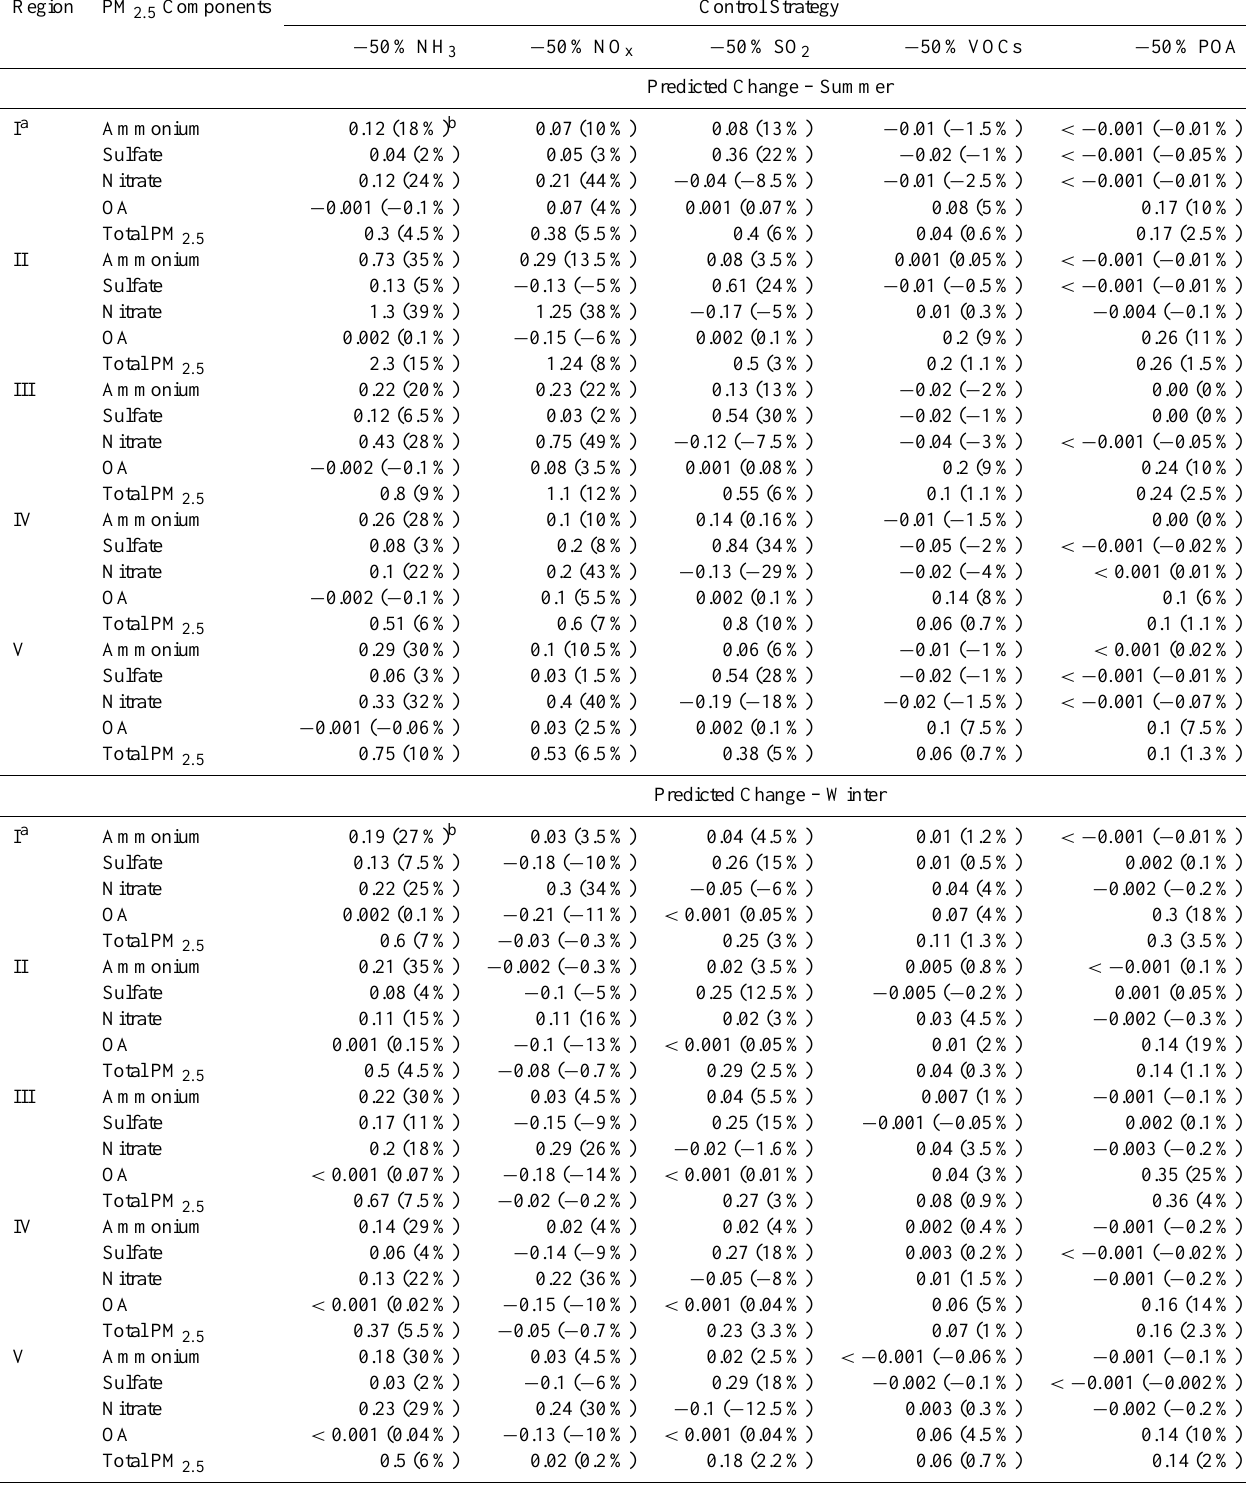
Table 2. Average predicted concentration reduction and percent average reduction of the major PM 2 . 5 components to a 50% reduction of NH 3 , NO x , SO 2 , VOCs and POA emissions, during the modelled summer and the modelled winter period. Region PM 2 . 5